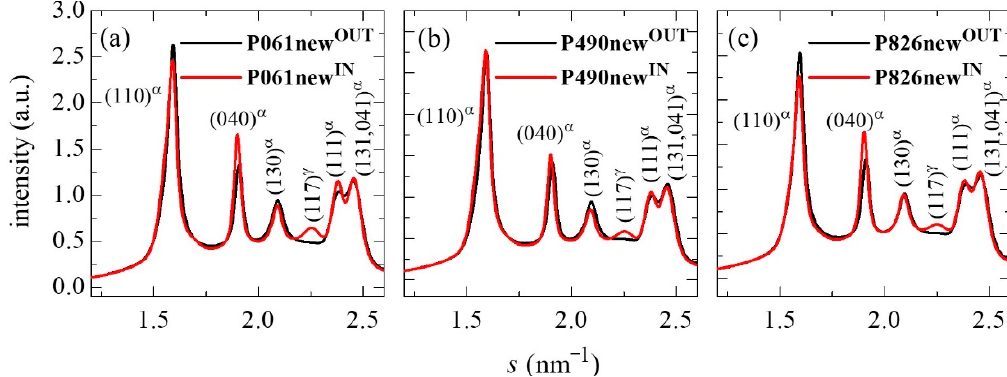
Figure 1. 1D WAXD profiles for the initial outer (new OUT ) and inner (new IN ) parts of the different pipes analyzed: ( a ) P061; ( b ) P490; and ( c ) P826.